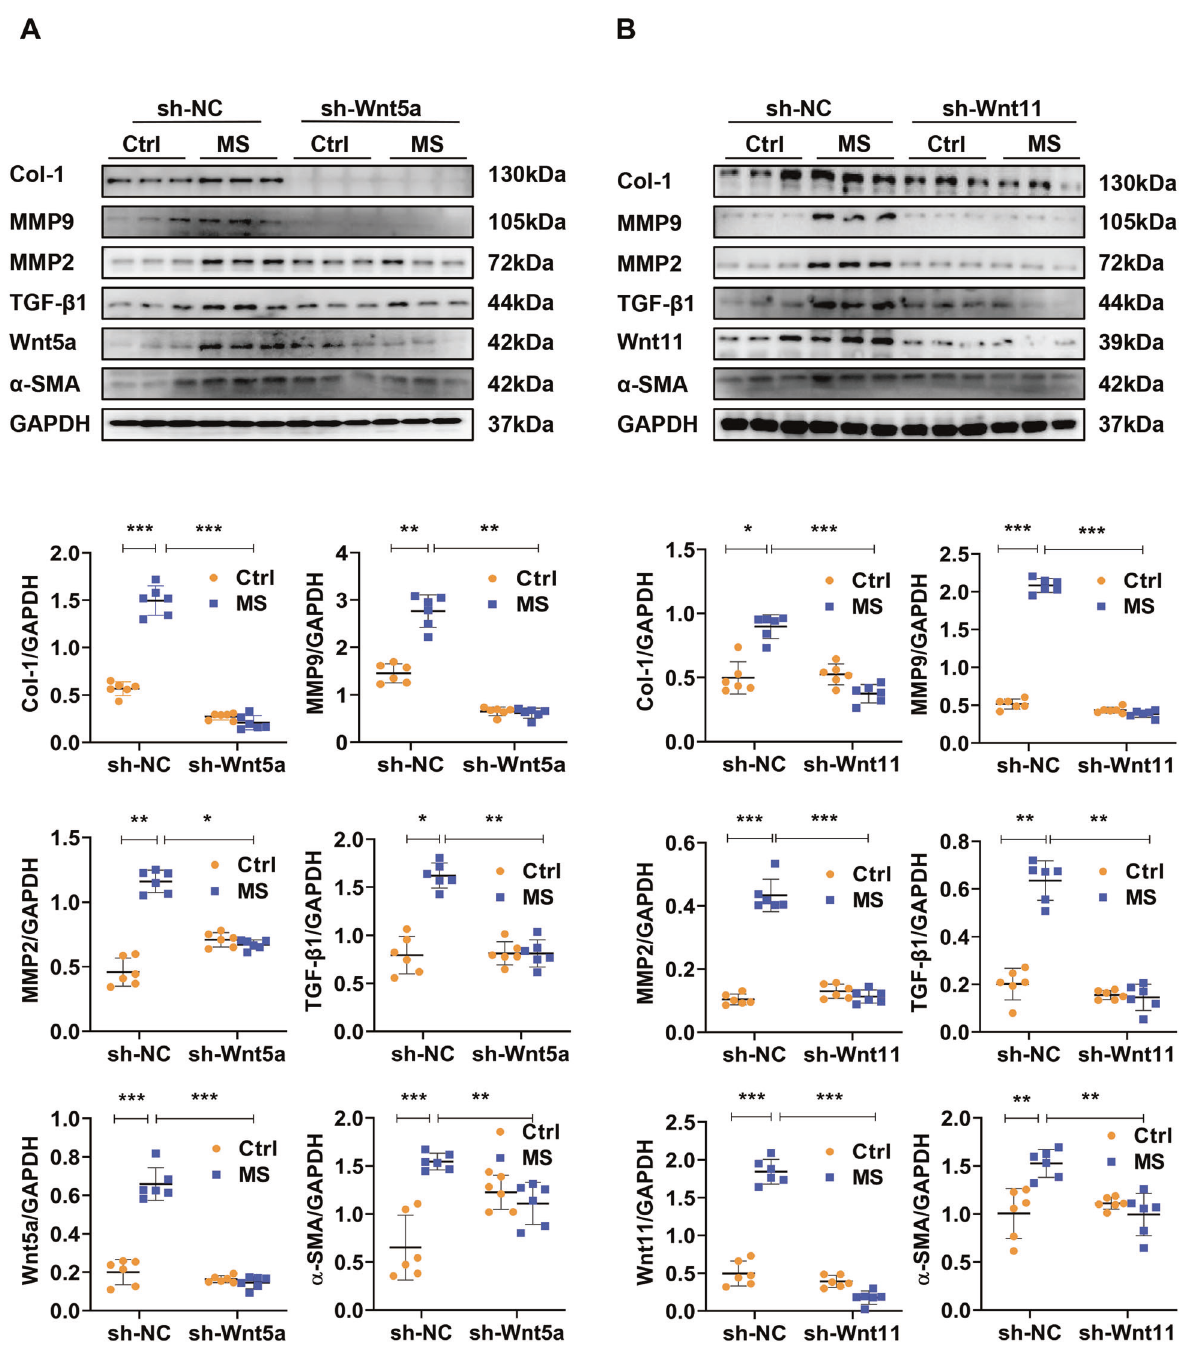
Fig. 5 Fibroblast-expressed Wnt5a or Wnt11 is involved in pro- fi brotic effects under pressure overload. A , B Western analysis of Wnt5a, Wnt11, Col-1, α -SMA, MMP9, MMP2, and TGF- β 1 in stretched (MS) or control (Ctrl) cardiac fi broblasts pre-transfected with sh-Wnt5a, sh-Wnt11 or sh-scramble (sh-NC) lentivirus, respectively. n = 6/group. All data were shown as mean ± SEM; * P < 0.05, ** P < 0.01, *** P < 0.001. SiRNA-FZD5 attenuates the activation of neonatal rat CFs EGFR inhibitor (Fig. 7C, D and Fig. S5C, D). But, in basic conditions, induced by Wnt5a or Wnt11 si-EGFR signi fi cantly suppressed the expression of FZD5 in CFs. In vivo, shWnt5a/11-AAV9 pre-injection signi fi cantly attenuated EGFR has been reported to be activated in CMs or CFs by MS the increased expression of FZD5 induced by TAC (Fig. S5A). To [12]. We also found EGFR inhibitor, erlotinib, attenuated the detect whether Wnt5a or Wnt11 activates fi broblasts by elevated Wnt5a or Wnt11 level in conditional medium of cultured FZD5 signaling, we abolished FZD5 expression by si-FZD5 CMs or CFs under MS (Fig. S5E, F). transfection in CFs with or without Wnt5a or Wnt11 treatment These data suggested that Wnt5a or Wnt11 activates CFs by (Fig. 8A, B). Wnt5a or Wnt11 signi fi cantly enhanced the expression EGFR signaling, and FZD5 may be involved in the effects. EGFR of Col-1, α -SMA, MMP9, MMP2, and TGF- β 1 in fi broblasts, and the activation is also a participant in the increased secretion of Wnt5a effects were signi fi cantly reversed by siFZD5 (Fig. 8A, B). P-EGFR, p- or Wnt11 from CMs or CFs under MS. Cell Death and Disease (2021)